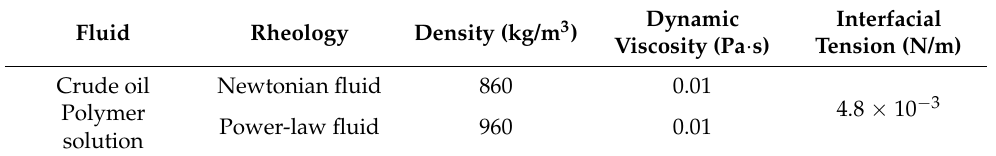
Table 1. Parameters of fluid used in this study.